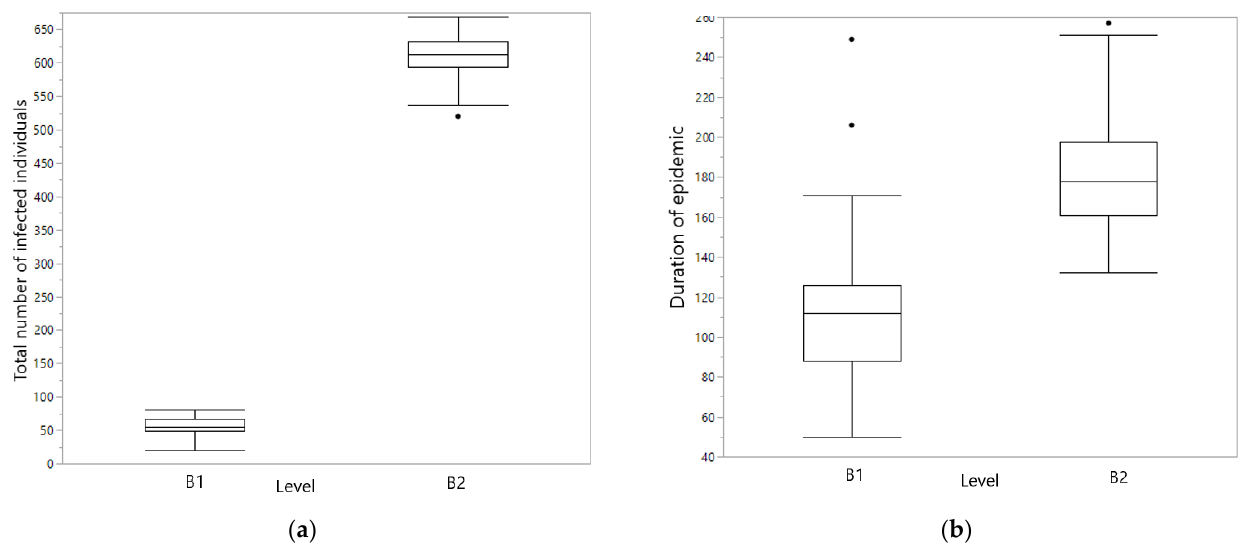
Figure 5. Boxplot of output responses: ( a ) total number of infected individuals; ( b ) duration of the epidemic.